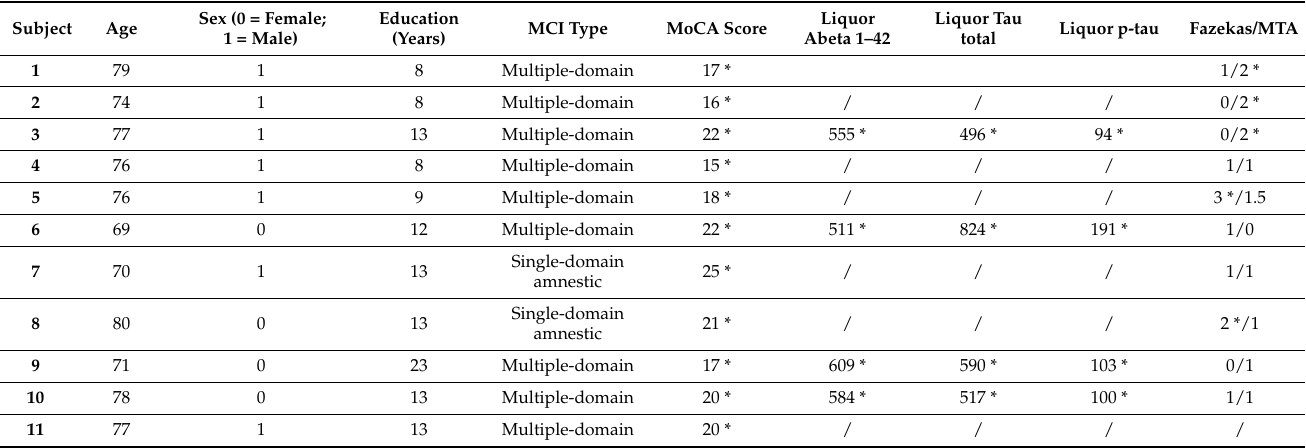
Table 1. Participants socio-demographical, neuropsychological, and cerebrospinal fluid and MRI biomarkers characteristics.